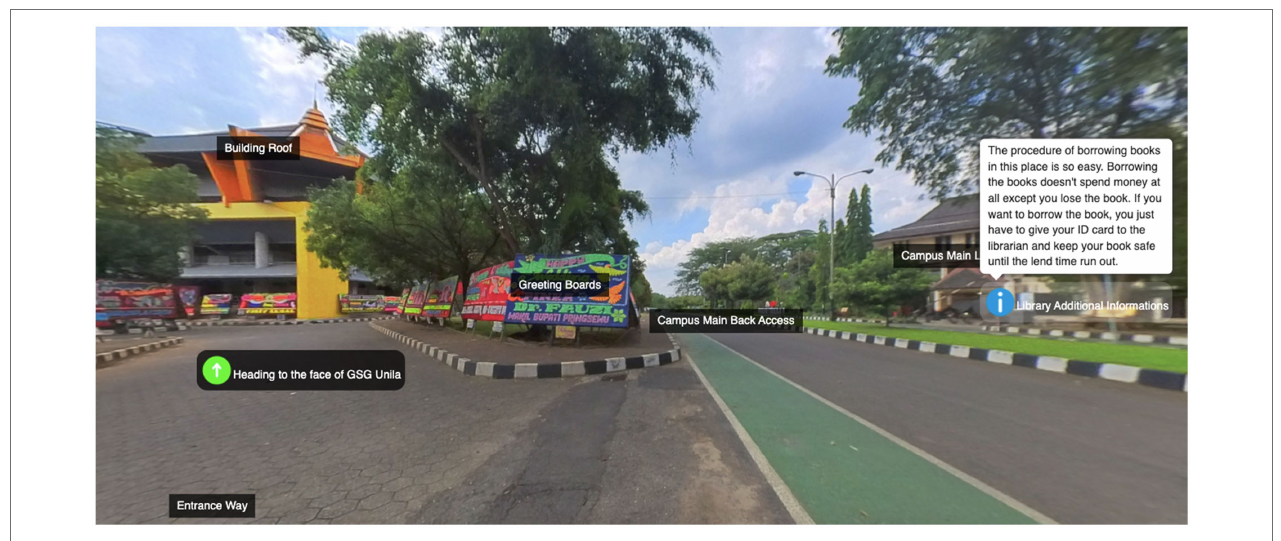
FIGURE 3 | Created content (panoramic tour) of student ID6.